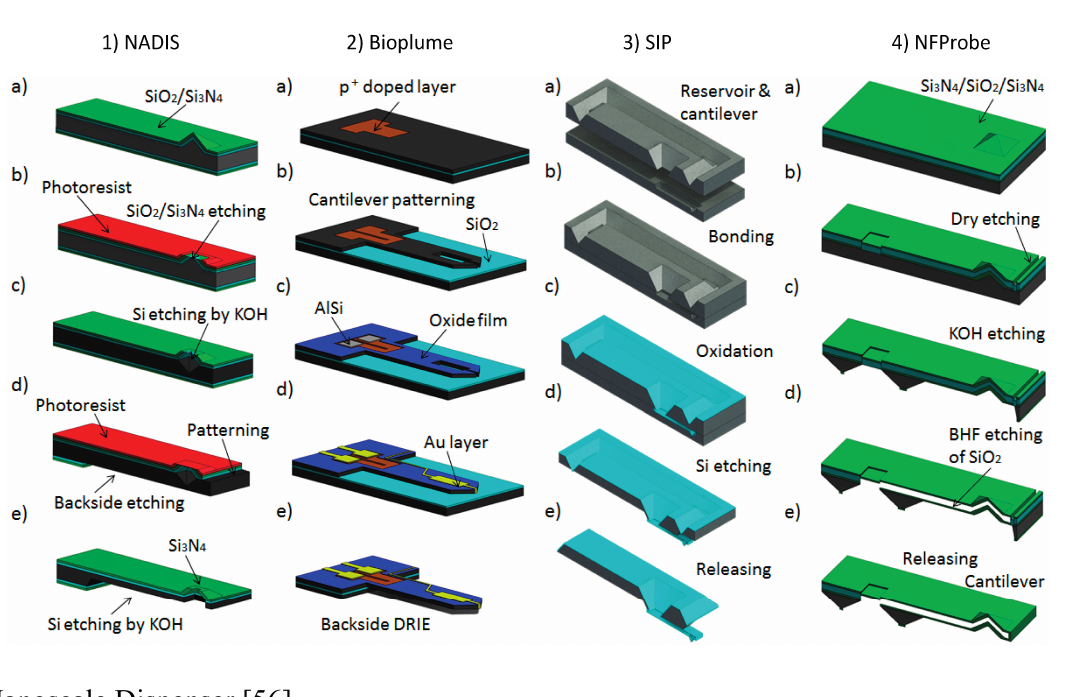
Figure 3. The microfabrication process steps for ( 1 ) Nanoscale Dispensor (NADIS), ( 2 ) Bioplume, ( 3 ) Scanning Ion Pipette (SIP), and ( 4 ) Nano Fountain Probe (NFProbe) are shown in separate columns. The details of the steps from ( a – e ) for each device are described in the